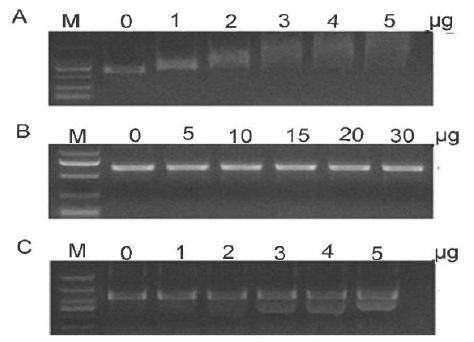
Figure 9. Degradation of dsRNA by recombinant PxdsRNases. M, marker. ( A ) PxdsRNase1; ( B ) PxdsRNase2; ( C ) PxdsRNase3.